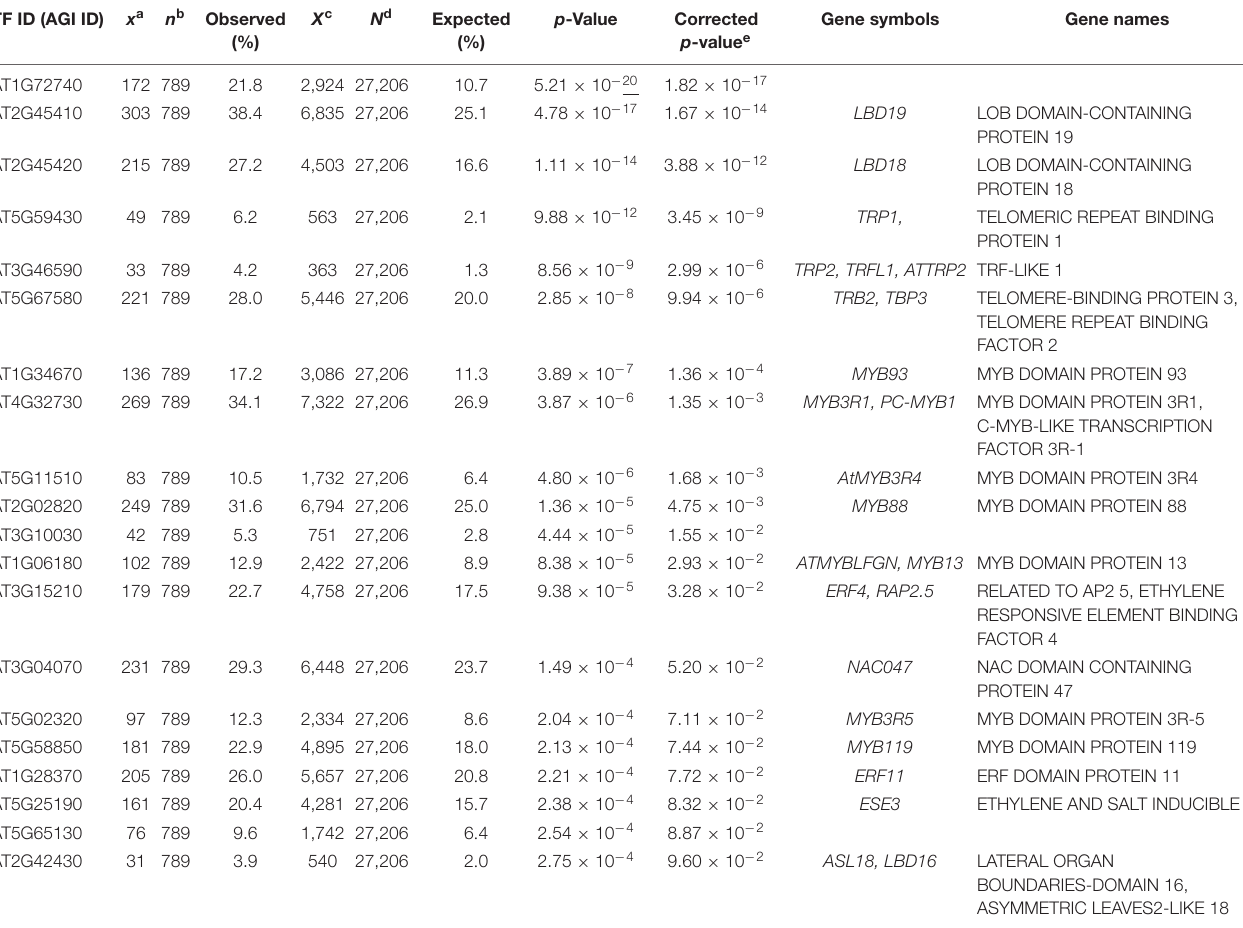
TABLE 3 | Summary statistics of enriched upstream TFs for up-regulated genes in Arabidopsis roots upon 1 µ M IAA treatment for 6 h (Omelyanchuk et al.,